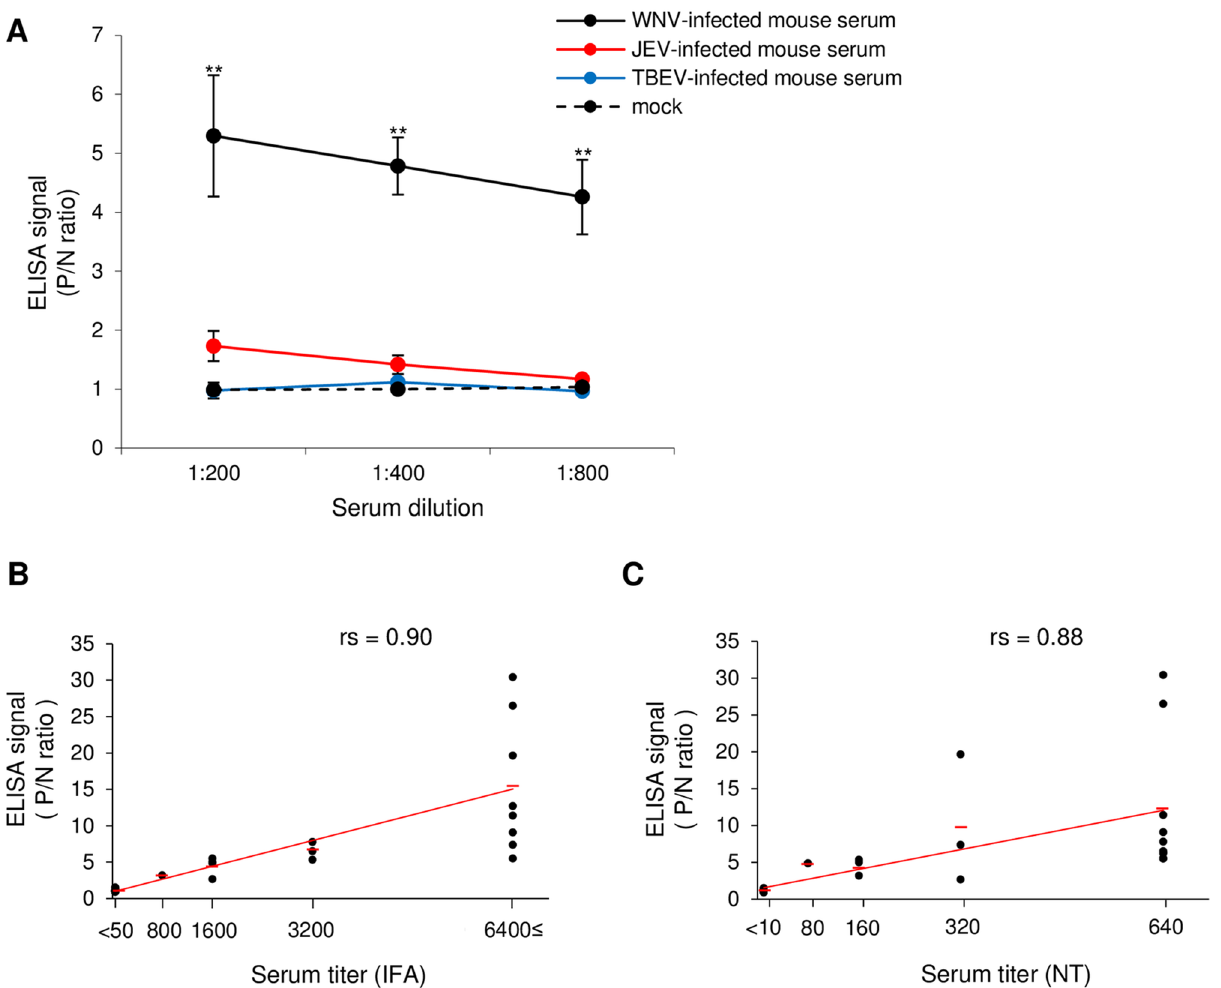
Figure 3. Sensitivity and specificity of the ELISA using full-length E protein. ( A ) Reactivity of WNV-infected (n = 3), JEV-infected (n = 3), and TBEV-infected (n = 3) mouse sera in the ELISA. Negative sera (mock; n = 3) were used as controls. Standardized serum from a WNV-, JEV-, or TBEV-infected mouse was serially diluted as described. The results were recorded as P/N ratios. The difference between the WNV-infected mouse serum and JEV-infected, TBEV-infected mouse serum, or mock was significant (**p < 0.01) according to the Tukey– Kramer test. ( B,C ) Correlation between the ELISA signal (P/N ratio) and results from the IFA or NT. Serum samples from mice infected with WNV were tested using ELISA and the results were compared to the titers estimated from the IFA ( B ) and NT ( C ). The strengths of the correlations (rs) were calculated as Spearman’s rank correlation coefficients (A, rs = 0.90; B, rs = 0.88). Red bars indicate approximate